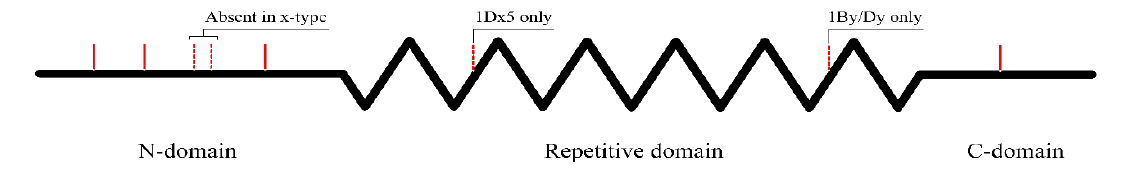
Figure 3. Schematic representation of the distribution of cysteine residues in x- and y-type HMW-GSs: the HMW-GS is comprised of three domains, the N- and C- terminal domains where most cysteine residues (red lines) are located, flanking a central repetitive domain. Two cysteine residues in the N-terminal of the y-type HMW-GSs are absent in the x-type. In HMW-GS 1Dx5, there is one additional cysteine residue in the repetitive domain near the N-terminal side, and there is an additional cysteine residue in the repetitive domain of the HWM-GSs 1By and 1Dy near the C-terminal side.